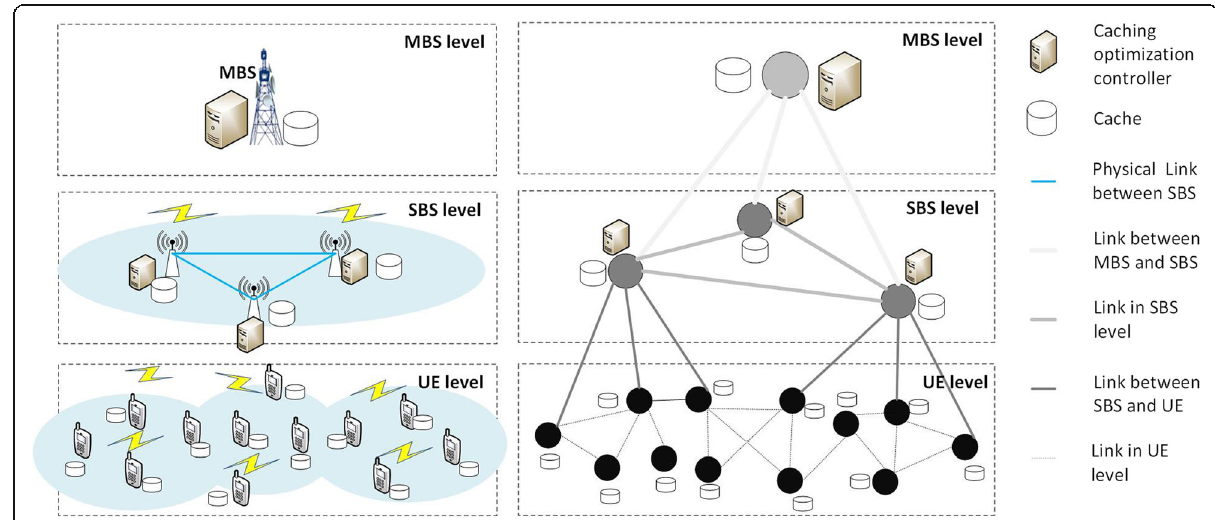
Fig. 1 System scenario of the cache-enabled hybrid radio access network